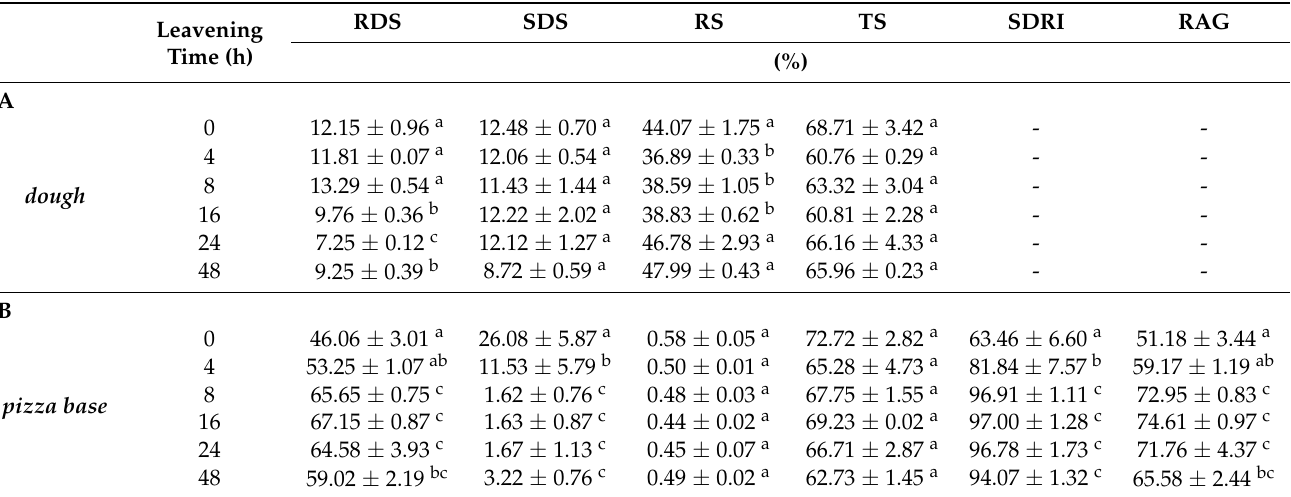
Table 3. In vitro digestible starches of dough ( A ) and wood oven-baked pizza base ( B ) at selected leavening